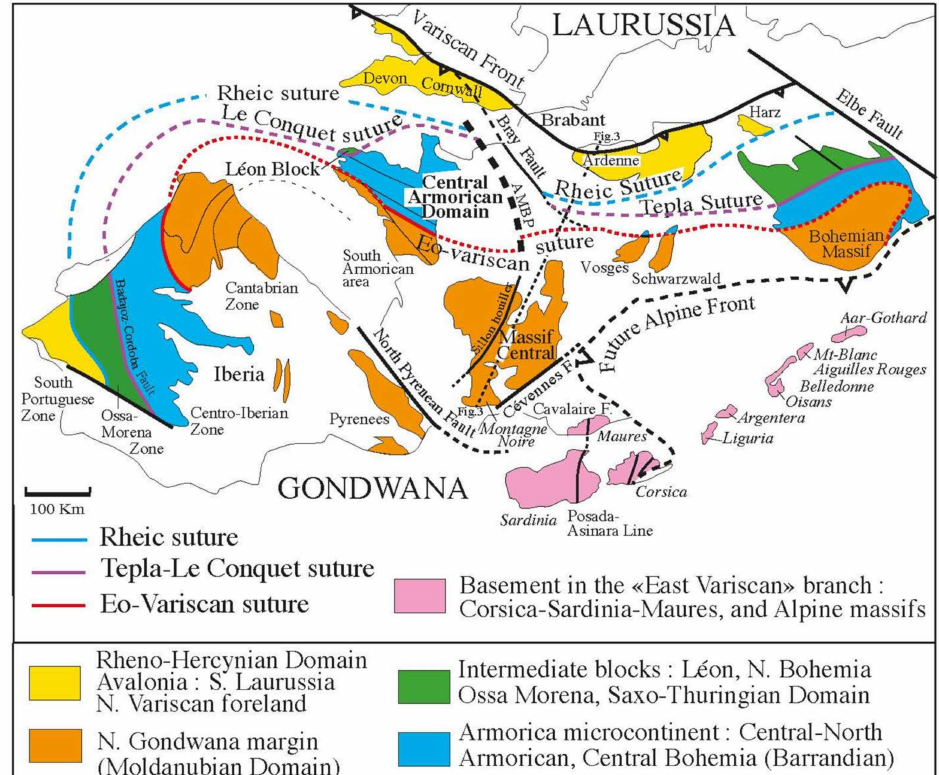
Figure 2. Tectonic map of the Variscan belt of Western Europe. Three ophiolitic sutures, namely Rheic, Le Conquet-Tepla, and Eo-variscan, separate several continental masses. From North to South, they are Laurussia (Avalonia) represented by the Rheno-Hercynian Domain, Saxo-Thuringian Domain, Armorica, and Moldanubian Domain corresponding to the North Gondwana margin. The Eastern Variscan branch is represented by the Corsica-Sardinia-Maures massifs, and Alpine basement massifs. Note that Iberia, Corsica-Sardinia, and Alpine External massifs are qualitatively restored to their Permian position before the opening of the Biscay bay and the Provence–Algeria